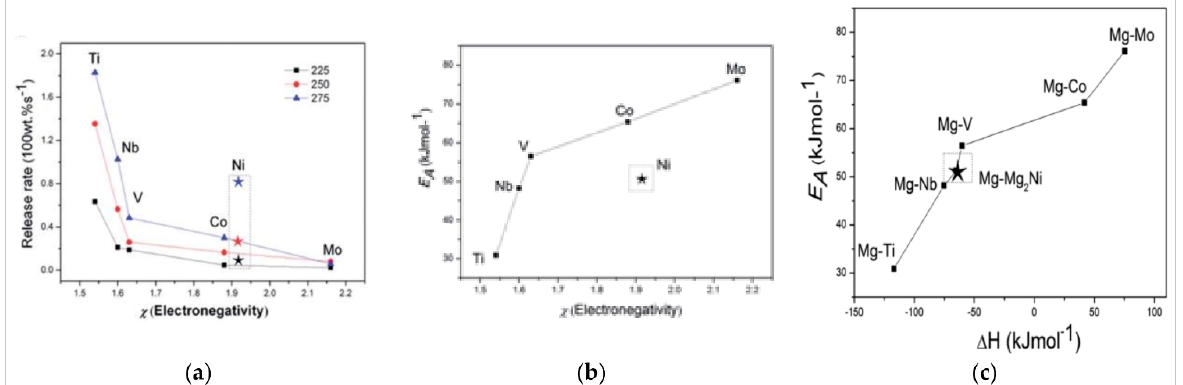
Figure 15. ( a ) Comparison in dehydrogenation average kinetics within 5 minutes of Mg–TM samples at 225, 250, and 275 °C. ( b ) Plot of E A (activation energy for dehydrogenation) in Mg–TM systems vs. χ of TM. ( b ) Plot of E A in Mg–TM systems vs. formation enthalpy of TM hydrides (TMH x ). ( a – c ) Reproduced with permission [102]. Copyright 2014, Royal Society of